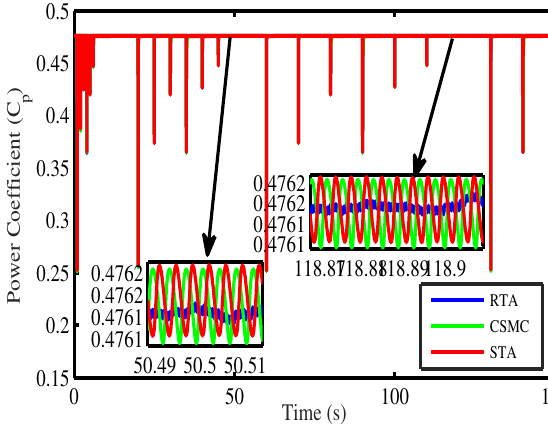
Figure 17. Tip speed ratio.